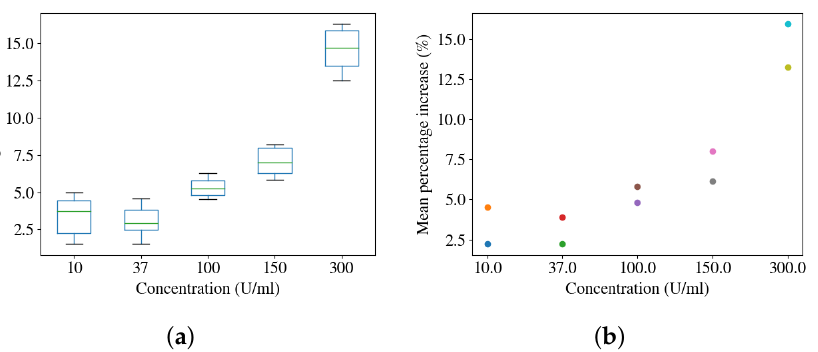
Figure 4. Antigen test results showing variation in real capacitance for different concentrations. ( a ) Samples over all frequencies. ( b ) Average real capacitance for each